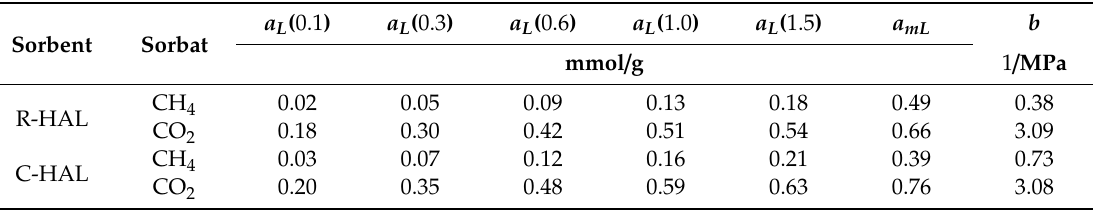
Table 4. Sorption points and Langmuir halloysite isotherm parameters.